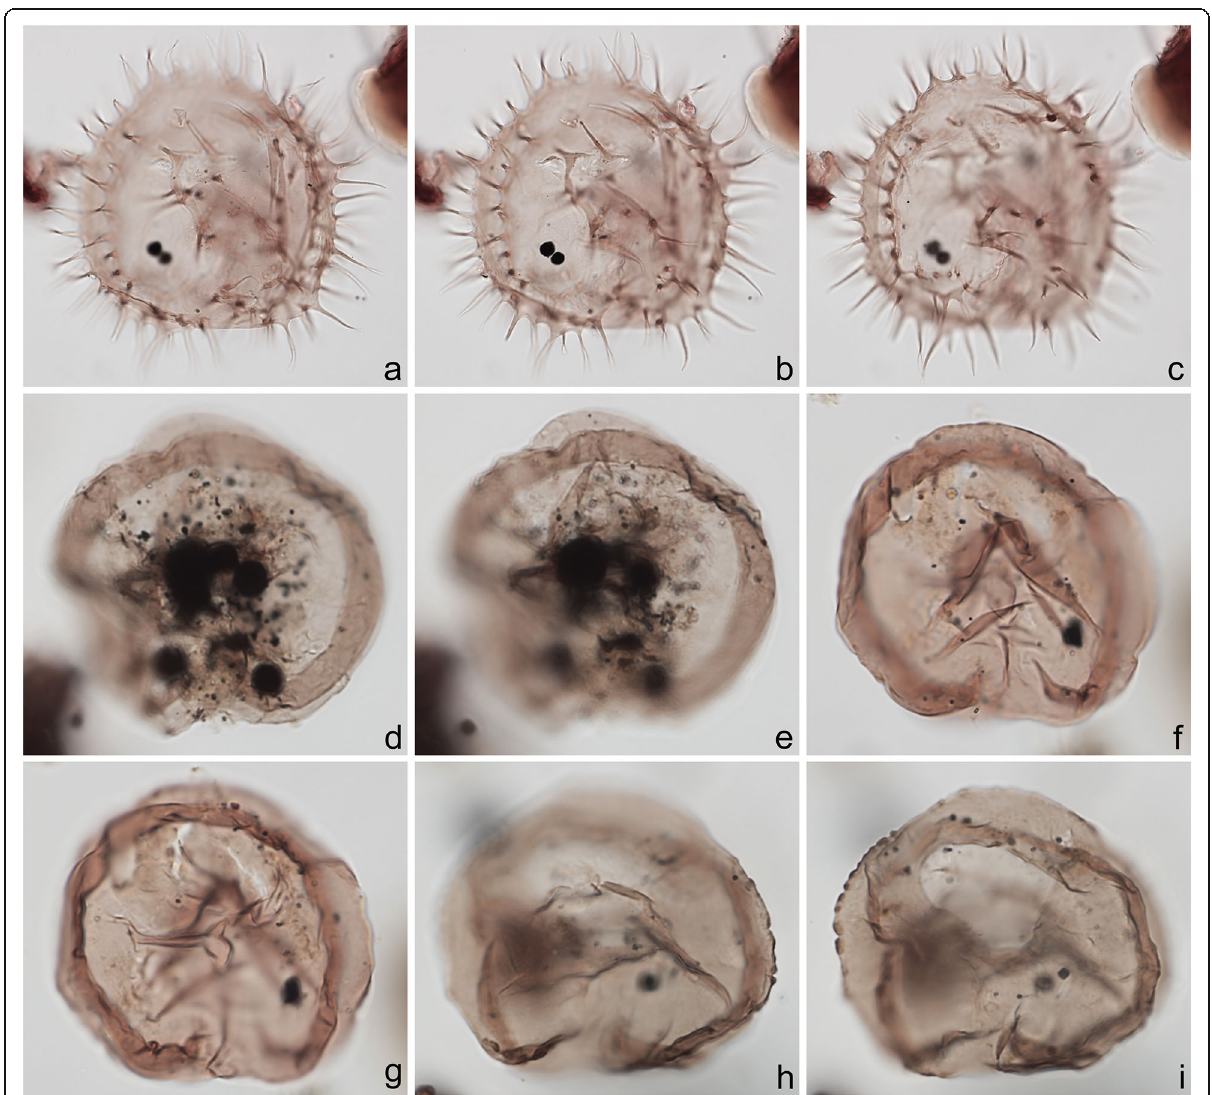
Fig. 11 Dinoflagellate cysts from the Chiba composite section. Max. dia. = maximum diameter. EF = England Finder reference. a – c Selenopemphix quanta , antapical view at upper, mid-, and lower foci; central body width 75 μ m, height 76 μ m; sample TB2 97, slide 3 (20 μ m) MJH, EF N13/3. d , e Selenopemphix nephroides , polar view at mid- and lower foci; cyst max. dia. 58 μ m; sample TB 66, slide 2 (10 μ m), EF G36/3. f – i Selenopemphix undulata ; f , g antapical view at upper and lower foci showing weak cingular crest undulations; cyst width 49 μ m; sample TB 12, slide 1 (20 μ m), EF L29/3; h , i antapical view at upper and lower foci showing pronounced cingular crest undulations; cyst max. dia. 56 μ m; sample TB 114, slide 1 (10 μ m), EF